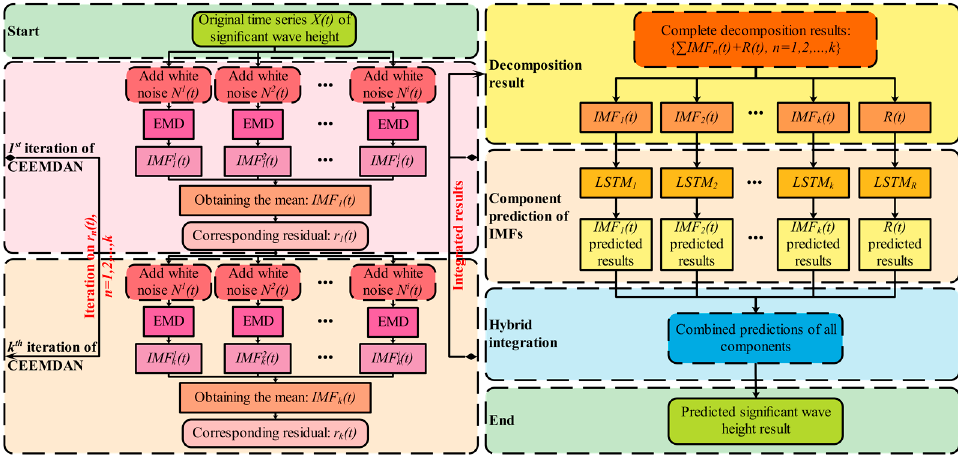
Figure 2. Flowchart of the integrated CEEMDAN-LSTM joint prediction model.